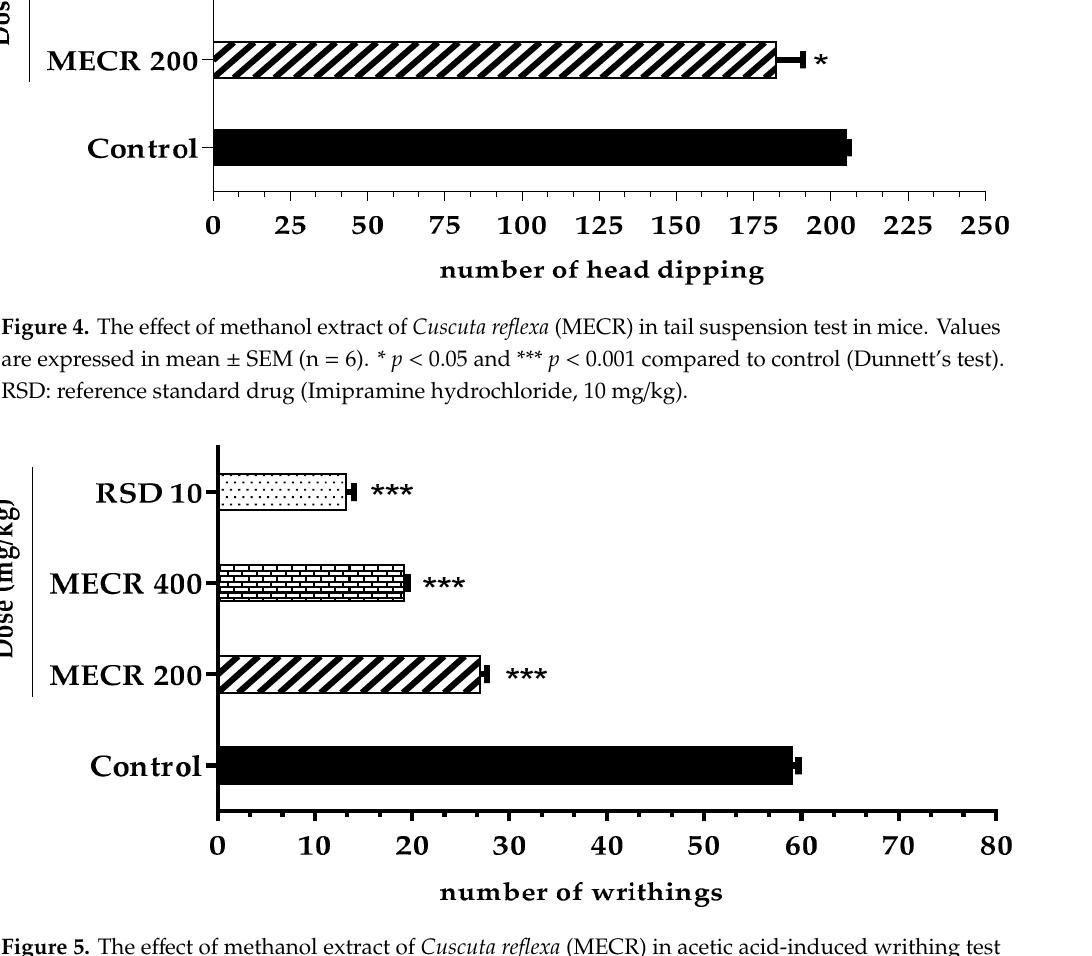
Table 1. Anti-nociceptive effect of MECR in formalin induced paw licking test in mice.